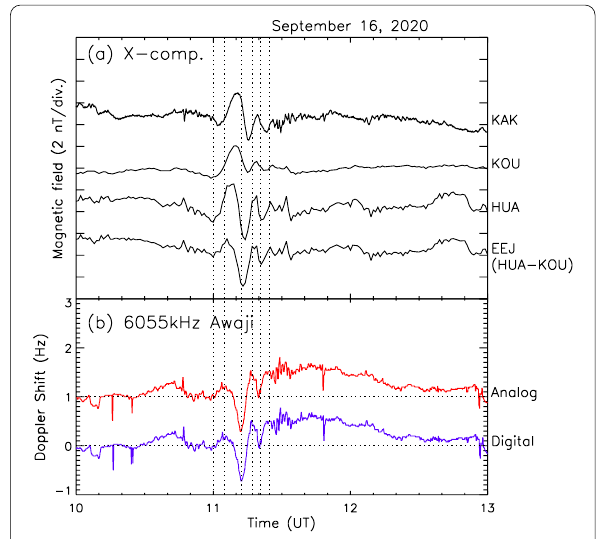
Fig. 12 The Pc5 event associated with the SC on 16 September 2020 at 10:58 UT. a Ground magnetometer data (magnetic X field) obtained at Kakioka (KAK: 1 s sampling) in Japan, Kourou (KOU: 1 min) in French Guiana, Huancayo (HUA: 1 min) in Peru and eastward equatorial electrojet calculated by subtracting magnetic X field at KOU from that at HUA (from top to bottom). b Doppler frequency data obtained by the analog and digital receivers at Awaji. At 11 UT, KAK and AWJ were located at 20 MLT, while KOU and HUA were at 07 MLT and 06 MLT,